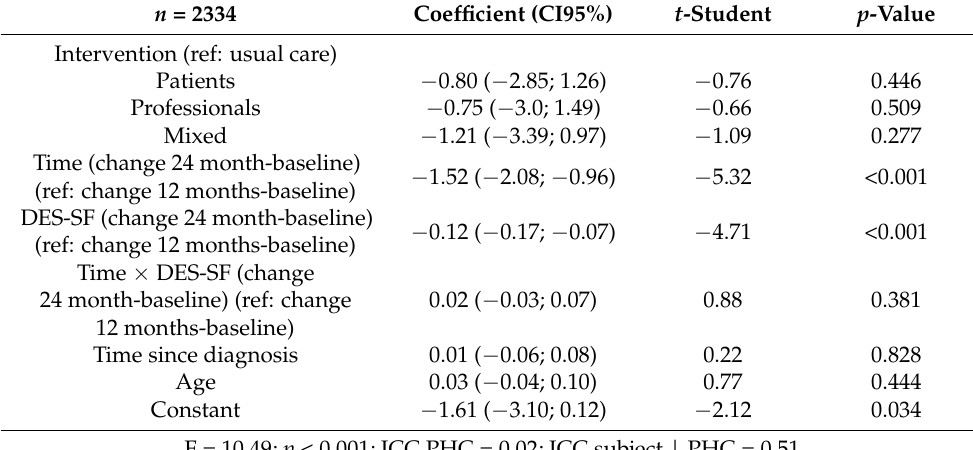
Table 6. Regression model for the change in depressive symptoms